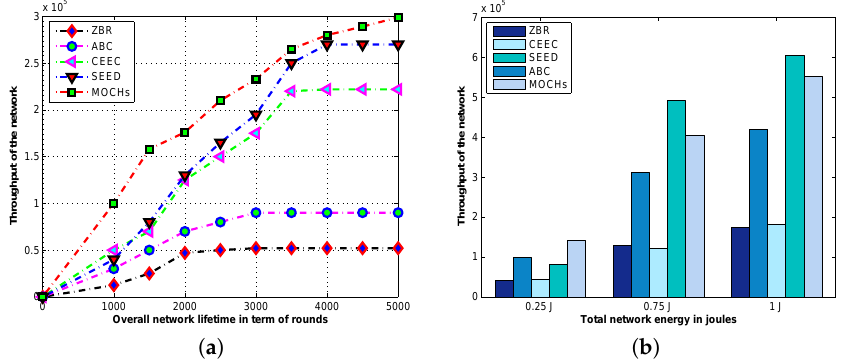
Figure 13. The total network throughput comparison of the proposed model against SEED, ABC, CEEC, and ZBR in the lifetime of the network on the basis of initial energies of the node. ( a ) The network throughput analysis; ( b ) The evaluation of network throughput with different initial